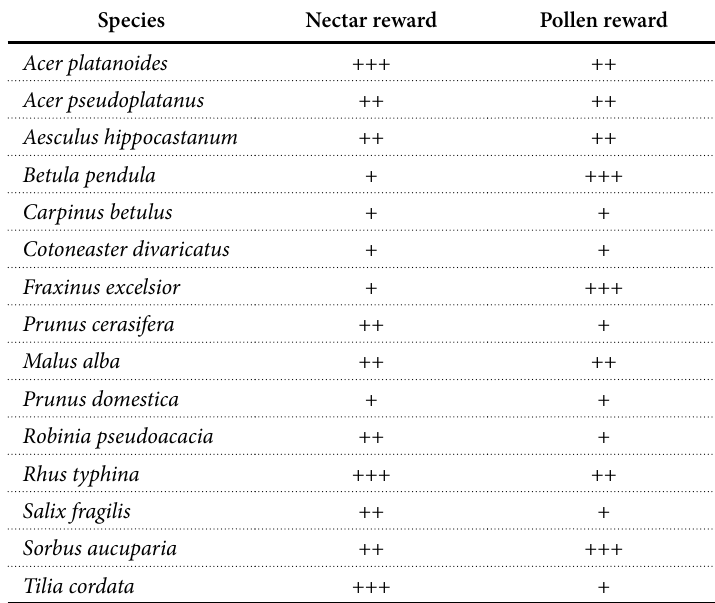
Tab. 1 Reward value of some plants inventoried in Felin Manor Park, Poland (based on literature data). Nectar reward Pollen